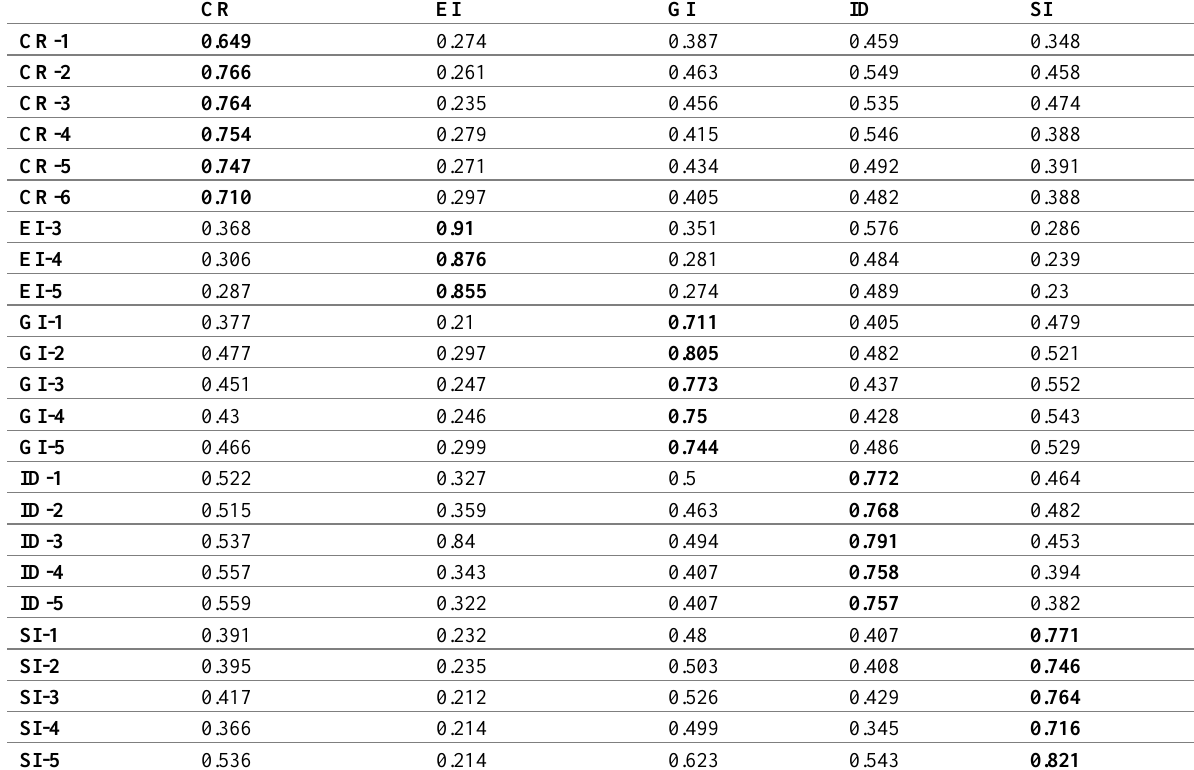
Table 2: PLS Output of Cross Loading